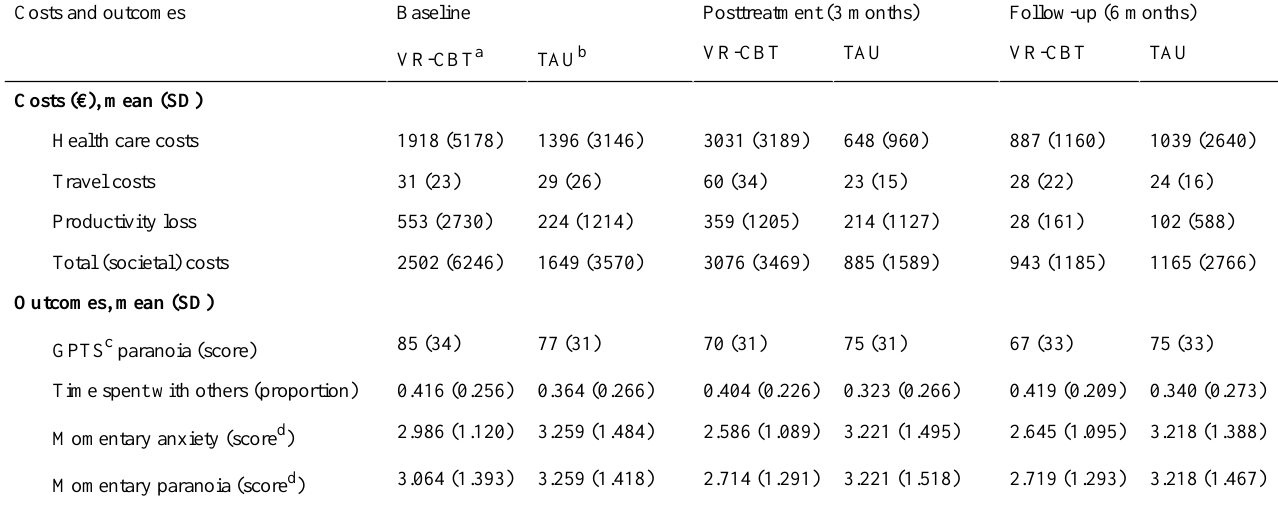
Table 2. Average per-participant costs per 3-month period in Euros for the year 2015 and average outcomes by measurement and